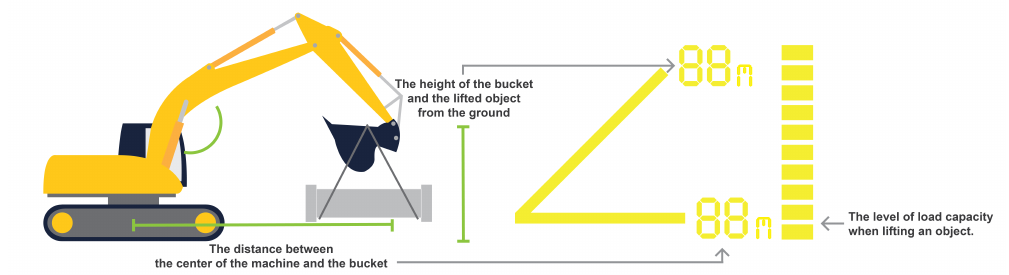
Figure 17. The meaning for each component in the relative load capacity concept that has been revised.